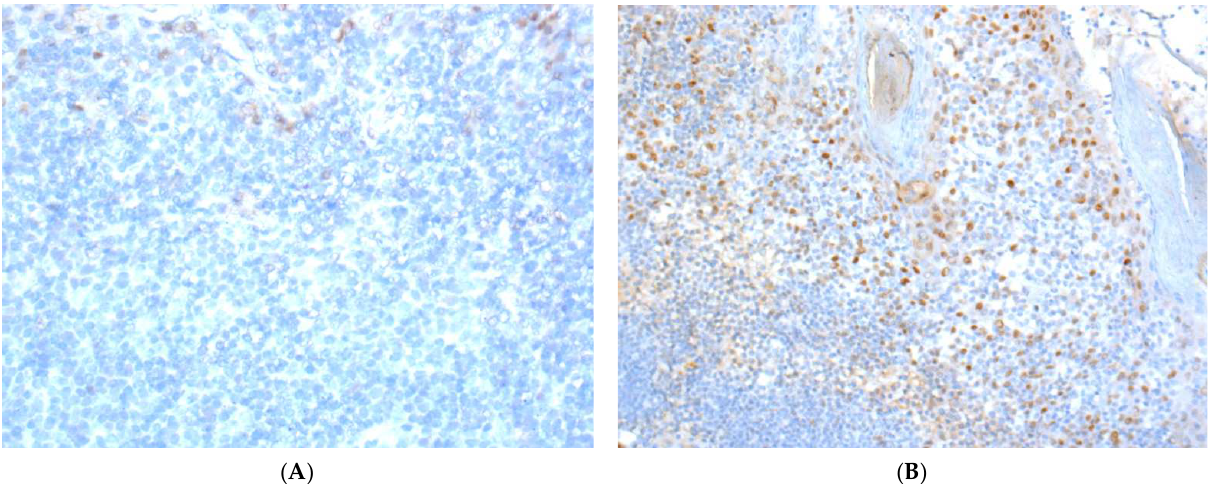
Figure 1. Immunohistochemical staining images of ERα in OSCC. ( A ) (40×): ERα-positive nuclear staining with weak intensity (Table 2; patient no. 3); ( B ) (20×): ERα-positive case with different intensities of nuclear staining (Table 2; patient no. 6; one out of three stained tumor tissue of this patient).